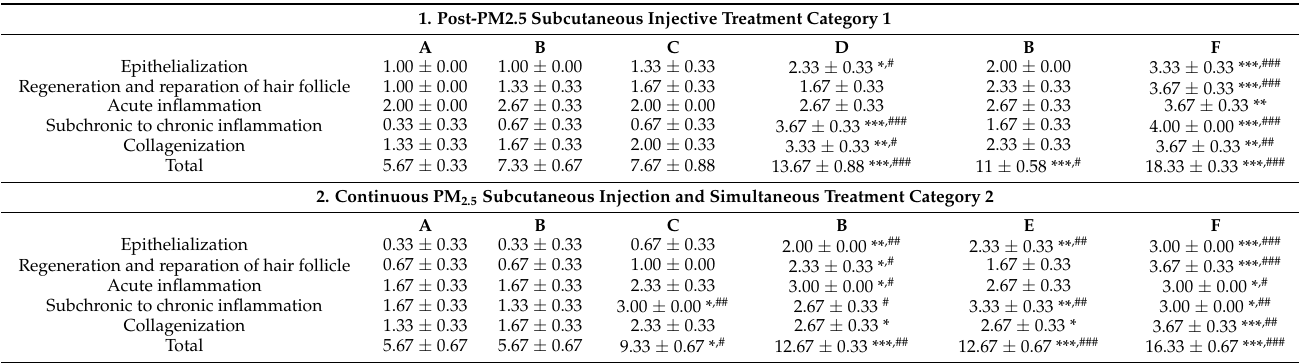
Table 1. Wound healing scores in the epidermis and dermis in the rats received Farn, Lipo-Farn, gel or none in post-PM 2.5 subcutaneous injection and continuous PM 2.5 subcutaneous injection